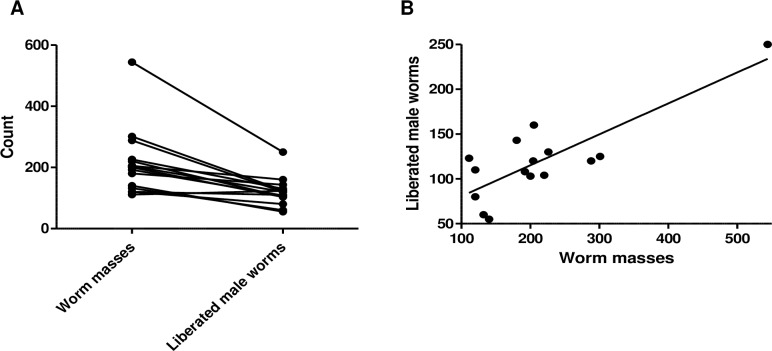
Correlation between the number of worm masses and the number of liberated adult O. ochengi male worms.Total number of worm masses obtained from cattle skin each time (n = 15) and the corresponding number of liberated male worms, A) Paired comparison of the number of worm masses and number of liberated male worms, B) Correlation between the number of worm masses to liberated male worms. Line shows linear regression best fit (Pearson r = 0.8171; p = 0.0002).